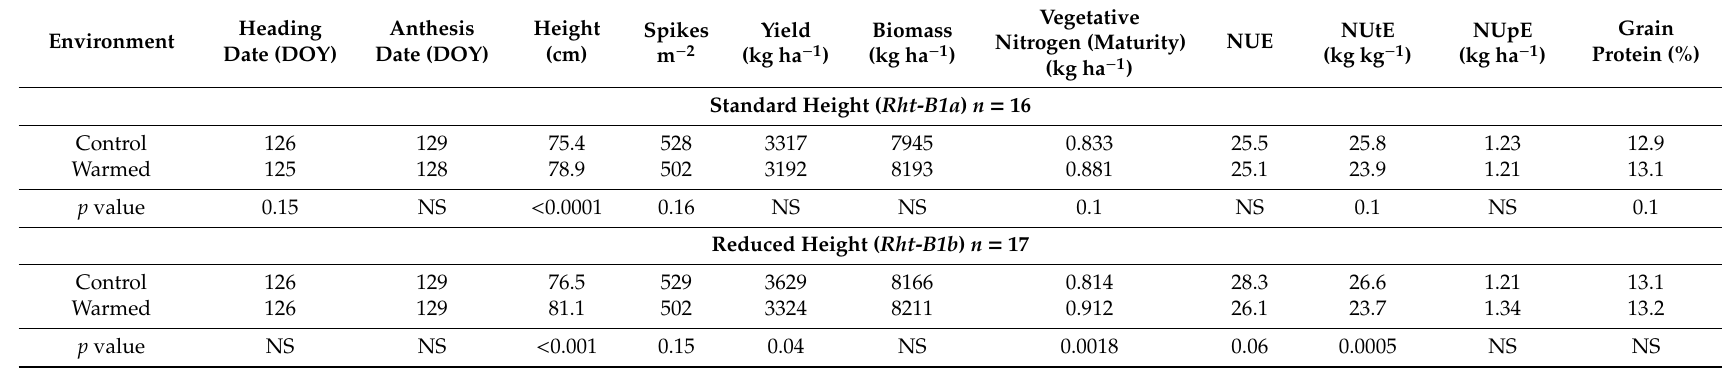
Table 5. Least squares means of agronomic traits † in control and passively warmed environments based on height classification at the Rht -B1 locus of 36 soft red winter wheat genotypes, 2015–2016 Lexington, KY. Environment